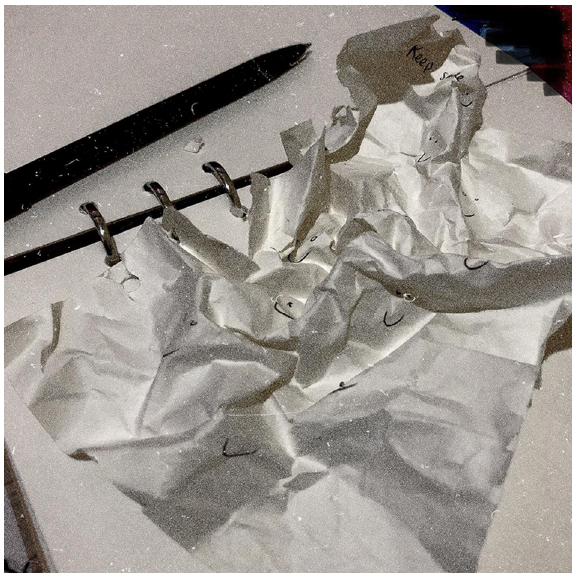
Crumbled Paper, a Symbol of the Enduring Psychological Pain From Dating Violence